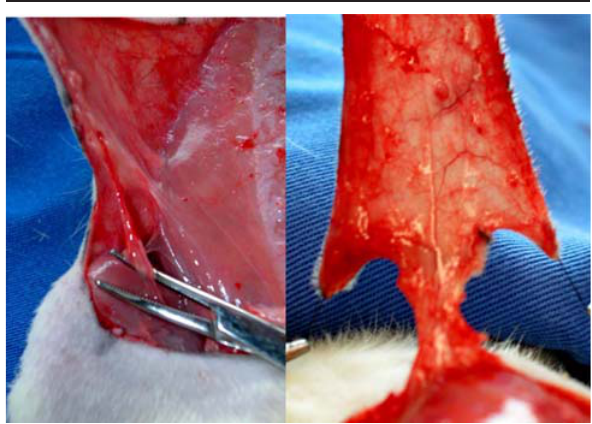
FIGURE 2 - Details of flap dissection. Right: inferior epigastric artery. Left: superior epigastric artery as